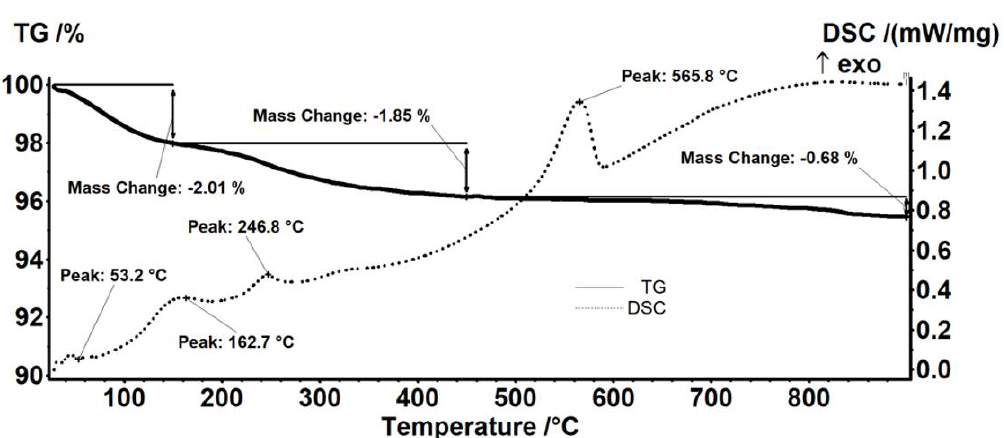
Figure 4. Thermogravimetric analysis of pristine Fe 3 O 4 nanoparticles.